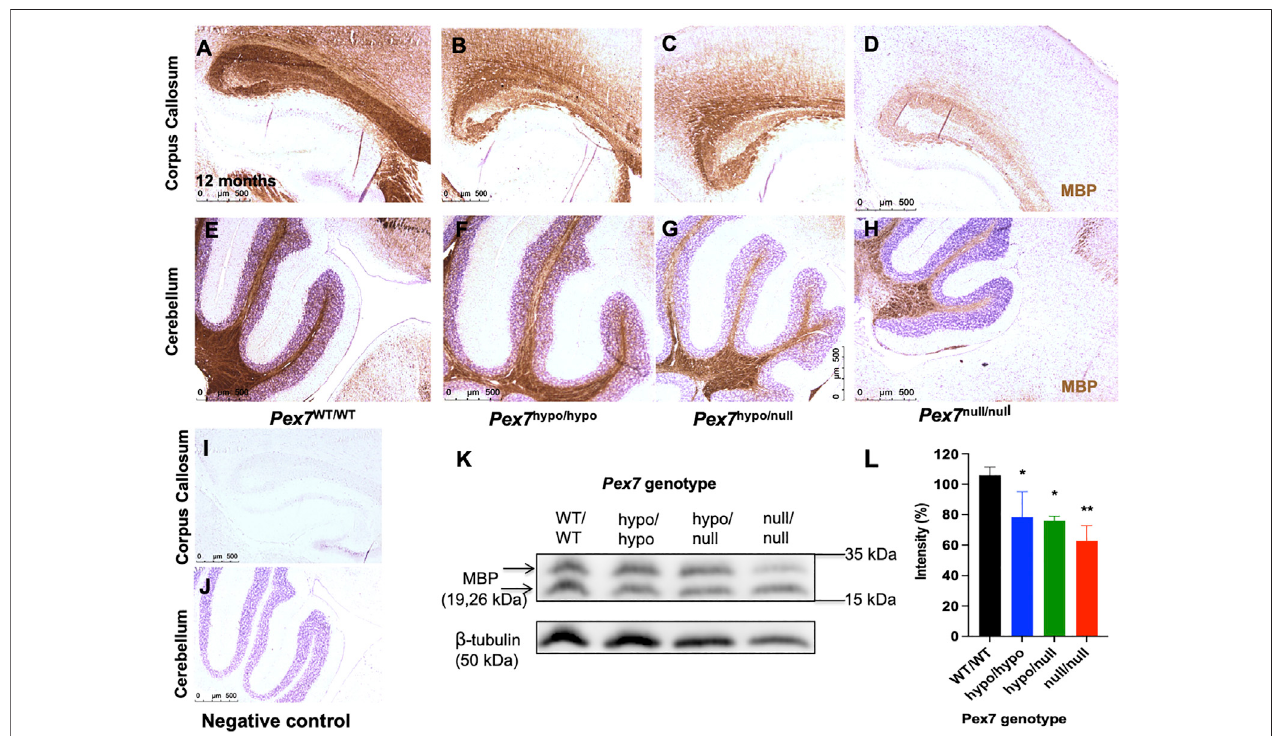
FIGURE 8 | Pex7 genotype correlates with the myelin content in brain tissues from 12-month-old Pex7 de fi cient mice. Sagittal sections of brain tissues: corpus callosum (A – D) andcerebellum (E – H) showgradedreduction inthelevelsofanti-MBPimmunohistochemicalstainingin12-month-old Pex7 de fi cientmicecomparedto their littermate controls. Slides were counterstained with hematoxylin (I, J) (Scale bar = 500 μ m). Graded reduction in theamount of MBP protein levels was found in the immunoblot and densitometric analysis of cerebellar homogenates from Pex7 de fi cient mice at 12 months of age (K, L) . ( n = 3 per genotype).